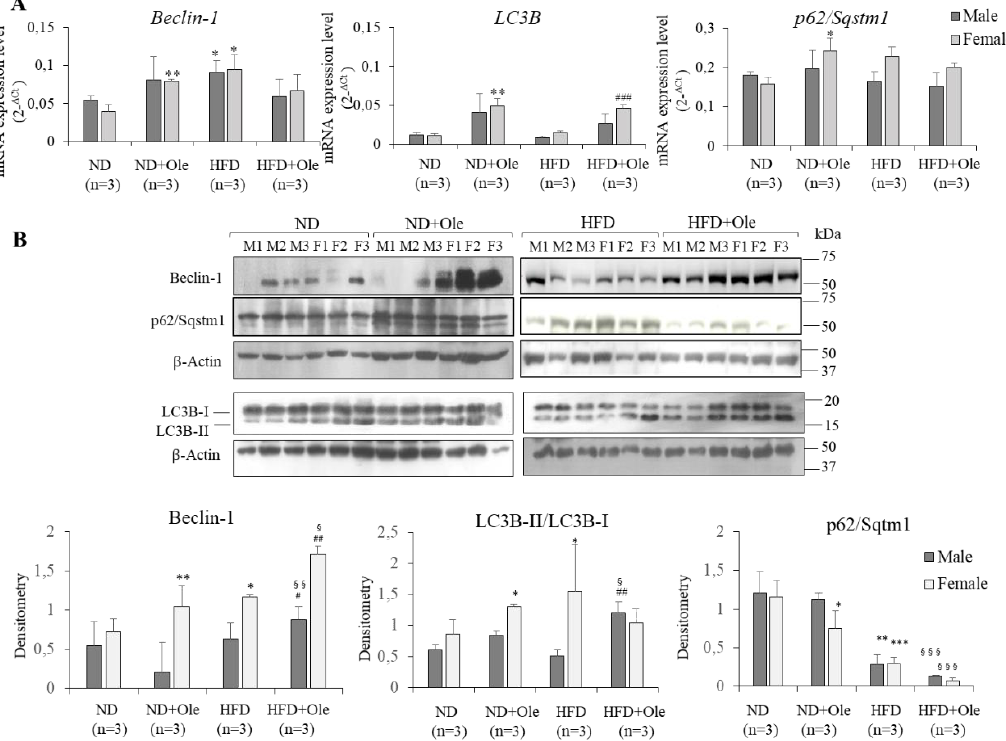
Figure 4. Ole induces early autophagic machinery ( A ) Beclin-1 , LC3B and p62/Sqstm1 expression, evaluated by Q-PCR, in ND and HFD in male (M) and female (F) mice in presence or not of Ole. Gene expression values are expressed as 2 − ∆ C t values. The results are reported as mean ± SD. ( B ) Western blot analysis and relative densitometry of Beclin-1, LC3B-II/I and p62/Sqstm1 protein expression in ND and HFD in M and F mice in presence or not of Ole. Values are expressed as fold mean ± SD. * p < 0.05, ** p < 0.01, *** p < 0.001 vs. ND; # p < 0.05, ## p < 0.01, ### p < 0.001 vs. HFD; § p < 0.05, §§ p < 0.01, §§§ p < 0.001 vs. ND + Ole.